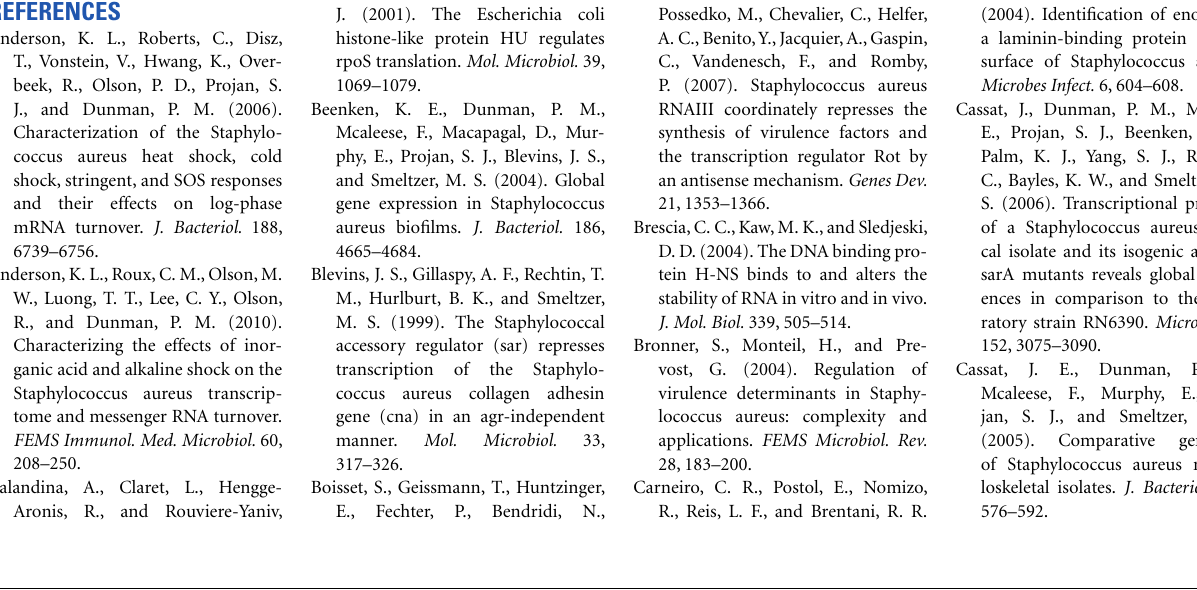
Table S5 | Mid-exponential growth phase transcripts bound by SarA in vivo